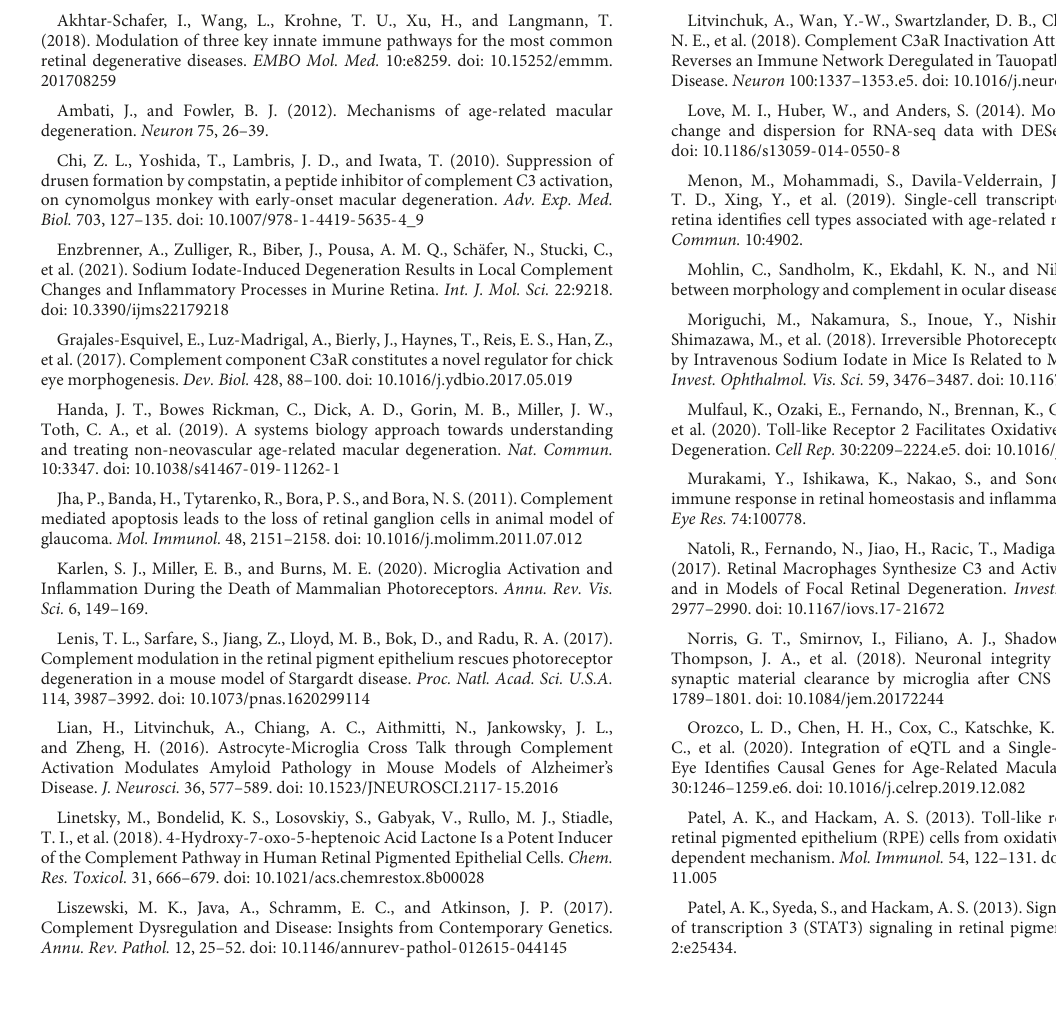
SUPPLEMENTARYFIGURE1 Schematic of the retina with a sample